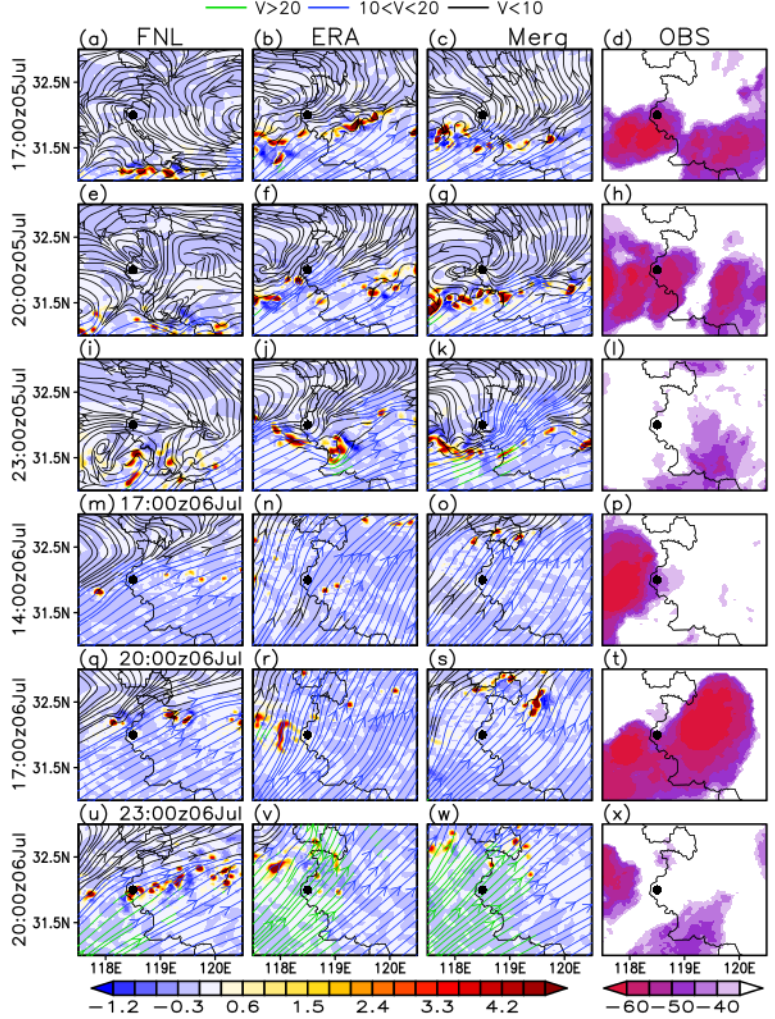
Figure 7. Comparison of the simulated 1.5-km streamlines, 5-km vertical velocity (shaded; units: m ⋅ s −1 ) and the observed TBB values (shaded on the right panel; units: K). ( a ), ( b ), ( c ) and ( d ) Show the patterns of the MUS in FNL, ERA and Merged respectively at 5 p.m. UTC on 5 July; and ( e – h ), ( i – l ) are the same as ( a – d ), but for 8 p.m. and 11 p.m. respectively. ( m - x ), is the same as ( a - l ), but for the TUS period. In the 1.5-km streamlines, black line shows the velocity is less than 10 m ⋅ s −1 , blue line shows the velocity is larger than 10 m ⋅ s −1 but less than 20 m ⋅ s −1 and green line shows velocity is larger than 20 m ⋅ s −1 . The thick black circles show the locations of NJ site.